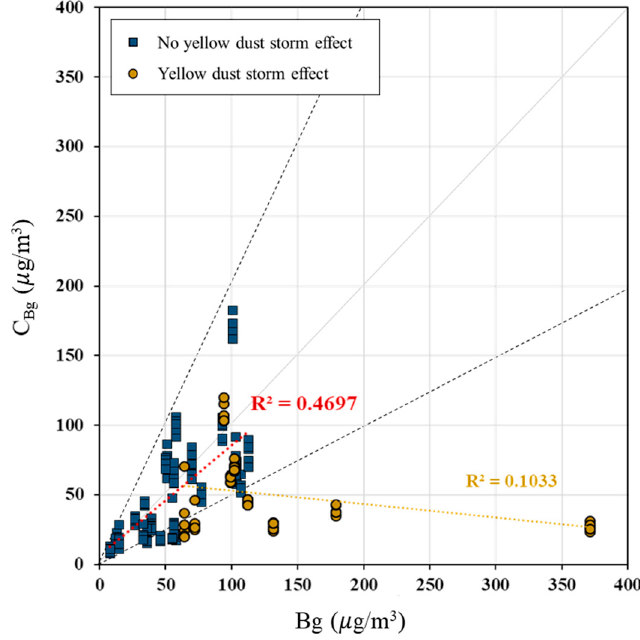
Figure 7. Concentration of Bg vs. C Bg on paved roads during traffic operation (classification due to the effects of yellow dust).